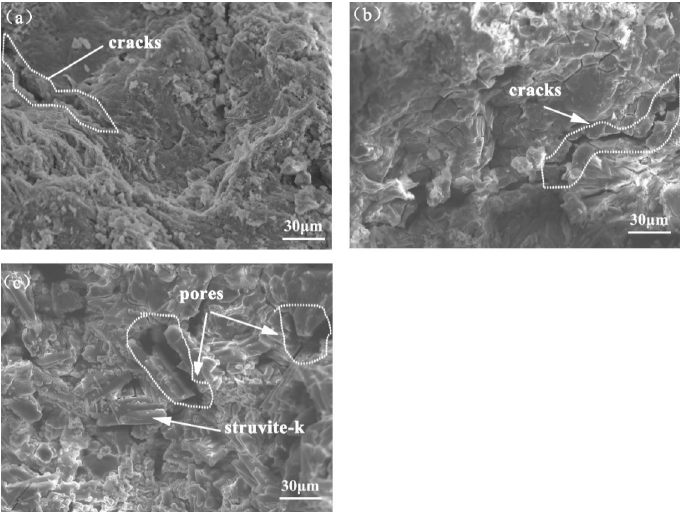
Figure 10. SEM morphologies of the MKPCs at 28 days: ( a ) reference without sodium alginate; ( b ) 1% sodium alginate; ( c ) 2% sodium alginate.